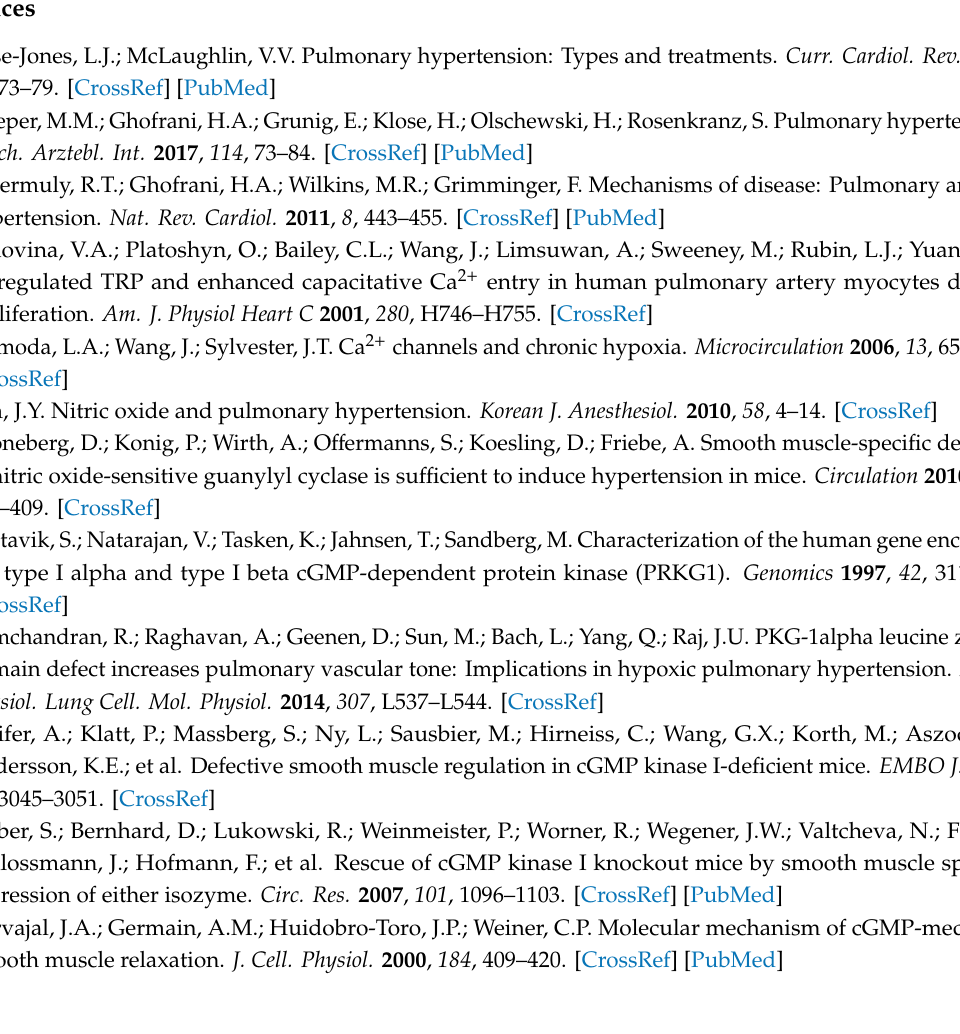
Figure S1: Immunostaining of hPASMCs from Donor confirm perinuclear and cytoplasmic localization of IP3RI, PKG1 β , and PKG1 α